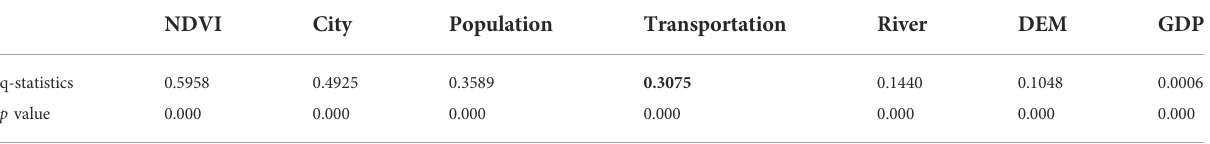
TABLE 5 Q-statistics table for the correlations between the various factors and the spatial distribution of scenic spots in Northwest China based on geographic detectors (scale size: 150 km × 150 km). NDVI